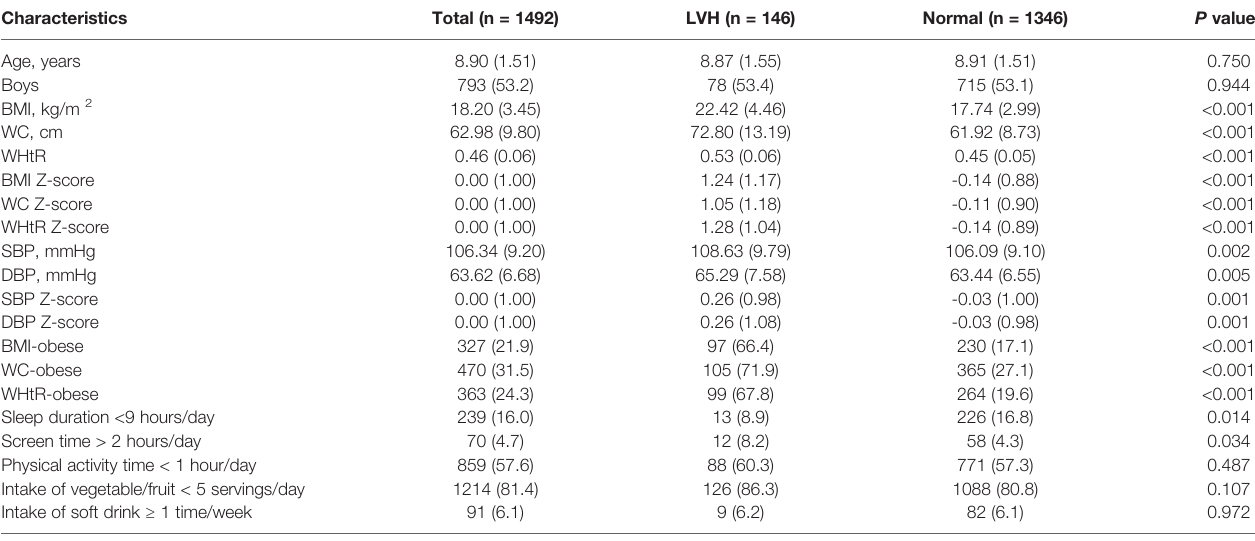
TABLE 1 | Characteristics of participants according to the presence of left ventricular